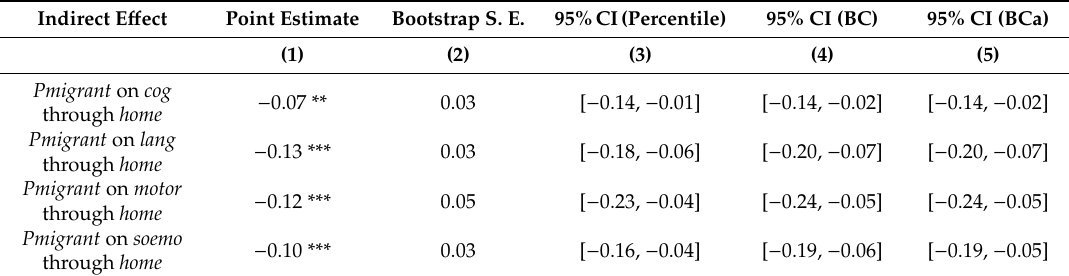
Table 3. Estimates of the indirect e ff ects of parental migration on child development through home environment.